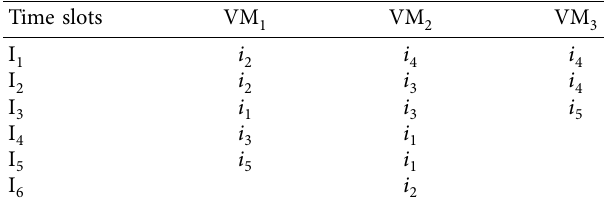
Table 2: Resource allocation for tasks.